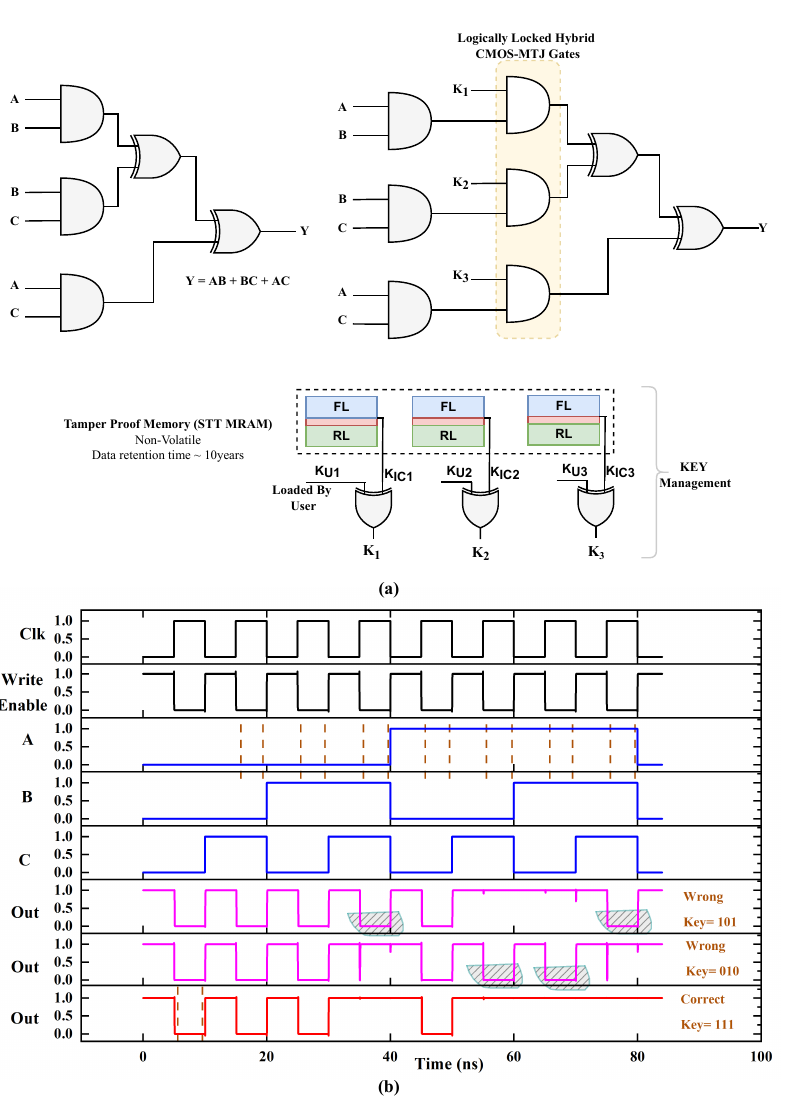
Figure 4. ( a ) Logic-locked netlist with keys. ( b ) Logic-lock operation with correct and incorrect key values with error highlighted.